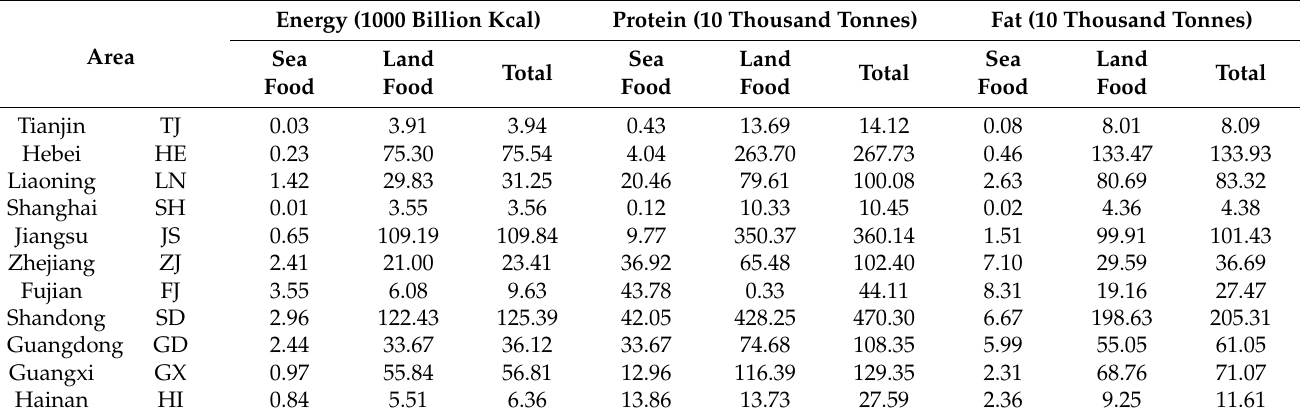
Table 1. Land and seafood nutrient production in coastal areas of